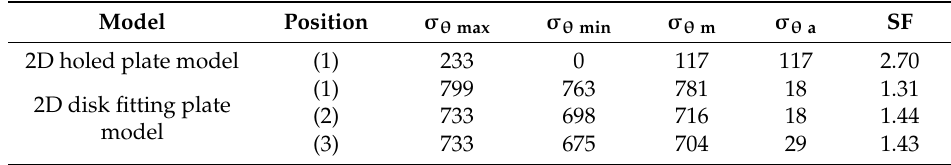
Table 7. Maximum stress σ θ max and minimum stress σ θ min , mean stress σ θ m and stress amplitude σ θ a in Figure 12 [MPa].